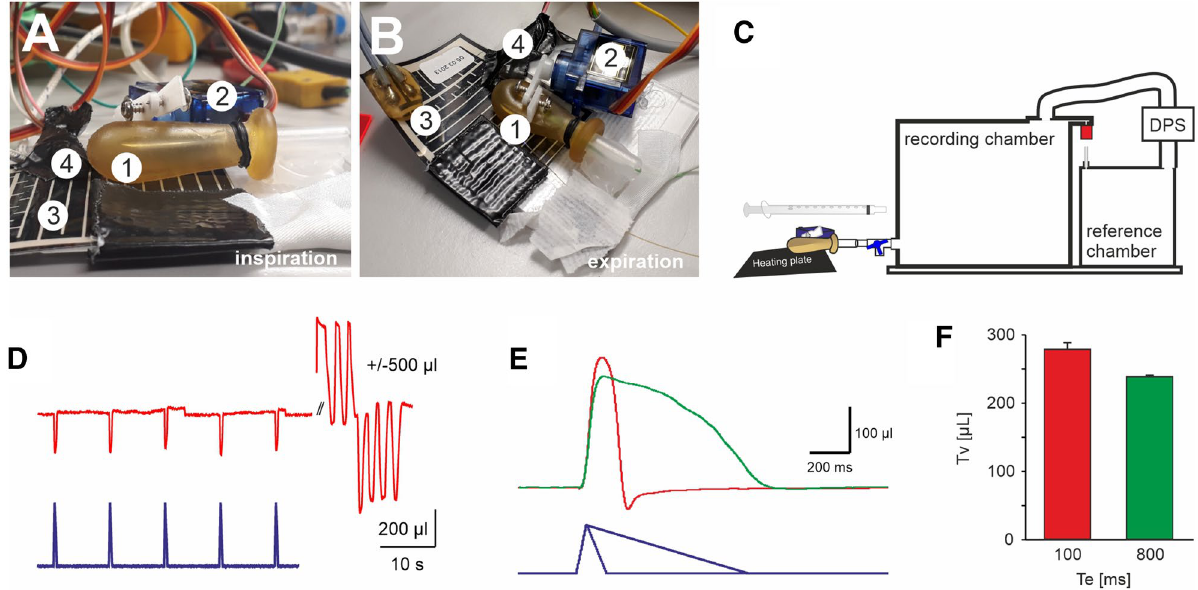
Figure 1. Measurement of the tidal volume (V T ) that is exchanged during a “respiratory” cycle of the artificial lung model (ALM). ( A , B ) Design of the ALM. ( A ) Lateral view of the ALM in inspiration (1) latex bulb, (2) servo motor with lever, (3) heating plate, (4) temperature sensor. ( B ) Top view of the ALM in expiration. ( C ) Schematic drawing of the experiment. To test the tidal volume of the ALM, it was connected to the plethysmography chamber. DPS = differential pressure sensor. ( D ) Recording of 5 cycles. Each inspiration (T I 50 ms, T E 100 ms) leads to a reduction of the pressure in the chamber (red trace). Blue trace analog out control signal. The pressure changes were calibrated by injection and withdrawal of 500 µl of air using a 1 ml syringe attached to the same port. ( E ) Enlarged (inverted) view of the calibrated pressure change (volume) from a respiratory cycle of the ALM with T I 50 ms, T E 100 ms (red) and T I 50 ms, T E 800 ms (green). ( F ) Average data of the volume that is exchanged during one respiratory